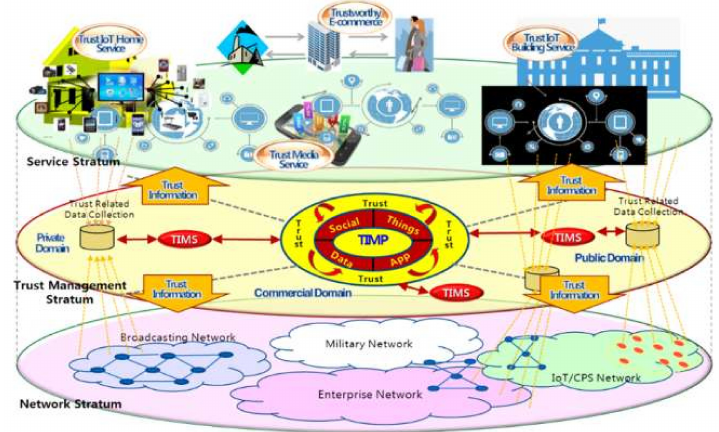
Figure 1. Converged trust information management.